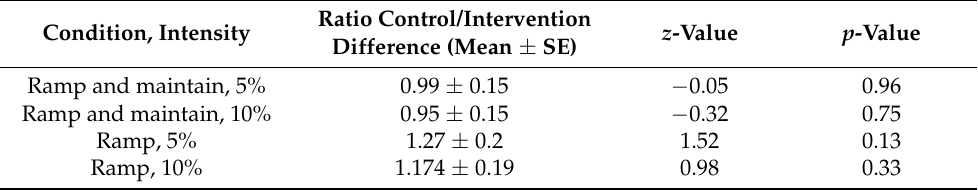
Table 3. Estimated group differences in the average instantaneous MU firing rate gradient (IFRG) of MUs across groups.